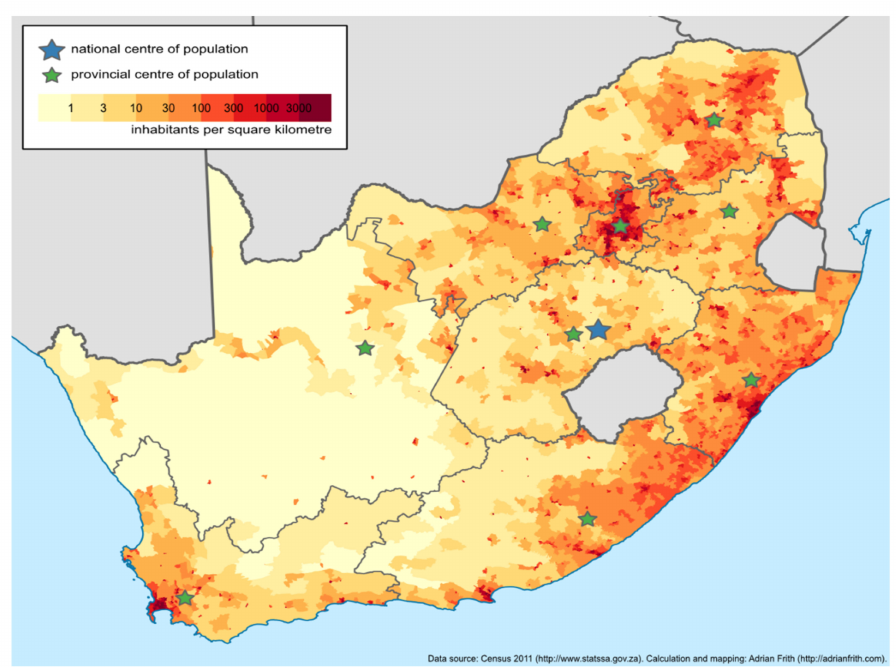
Figure 3. Map by Adrian Frith [15], indicating the number of inhabitants per square kilometre in South Africa as recorded in the last census in